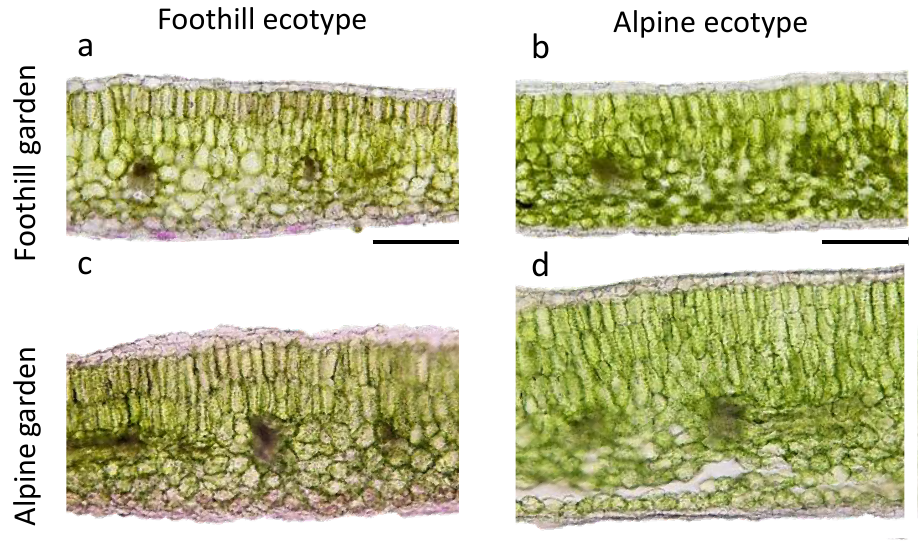
Figure 4. Ecotypic differences in leaf anatomy of plants from alpine and foothill A. arenosa populations submitted to a reciprocal transplantation experiment, visualized by light microscopy. Representative examples of leaf cross sections are shown for plants from ( a , c ) a foothill population and ( b , d ) an alpine population that were grown together in ( a , b ) a foothill and ( c , d ) an alpine common garden. Scale bars: 200 µm.